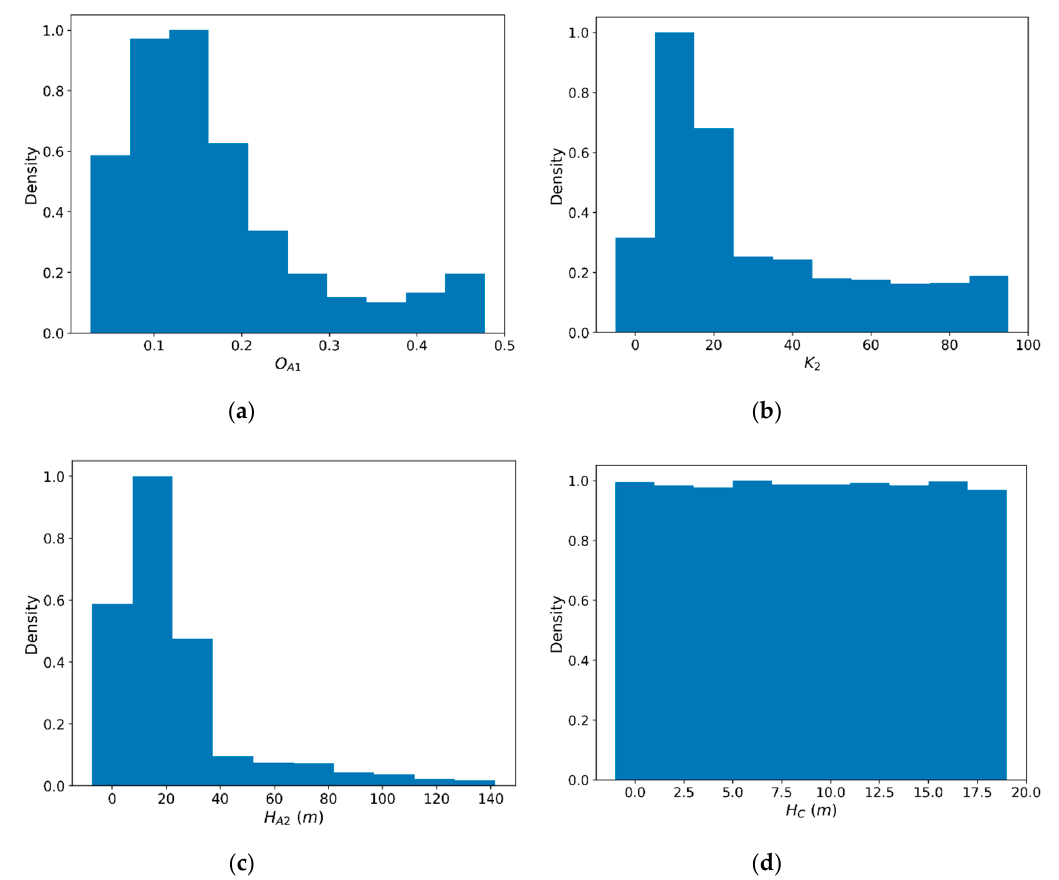
Figure 4. DREAM derived posterior distribution of parameters for Station 1,002,640 ( a ) O A 1 (outlet constraint of the lower outlet at Tank A , initially ranged from 0~0.5), ( b ) K 2 (soil moisture exchange rates between the top two tanks, initially ranged from 0~100), ( c ) H A 2 (storage level to the upper outlet at Tank A , initially ranged from 0~150 m) and ( d ) H c (storage level to the outlet at Tank C , initially ranged from 0~20 m). Water 2020 , 12 , x FOR PEER REVIEW